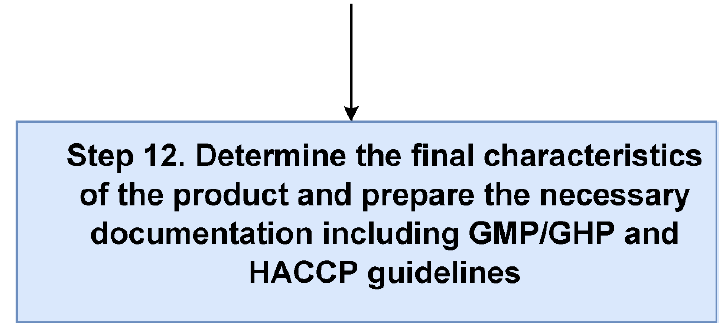
Figure 1. Protocol for designing new functional food with addition of food industry by-products using the Design Thinking methodology.